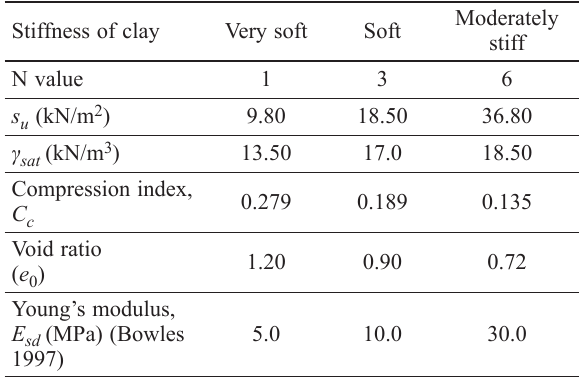
Table 3. Typical Soil parameters considered for study as used in Bhattacharya et al. (2004) Stiffness of clay Very soft Soft